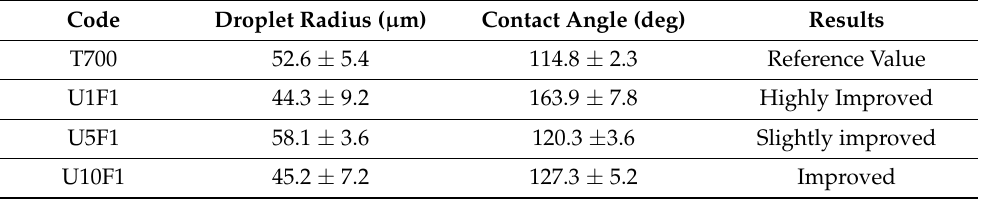
Figure 7. Contact angle measurements of CNF sized fibres with different wt.%: ( a ) T700 (reference), ( b ) 1 wt.% CNF-U1F1, ( c ) 5 wt.% CNF-U5F1 and ( d ) 10 wt.% CNF-U10F1. Table 2. Average measured contact angles and average diameter of the measured